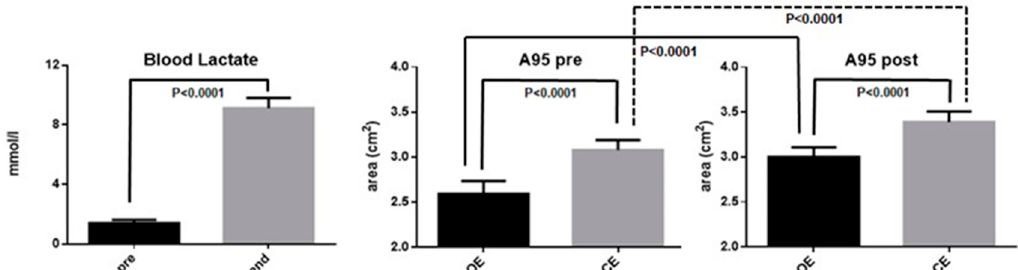
Figure 2. It can be seen, on the left, the mean value of blood lactate before and at the end of the exhaustive exercise. There are also shown the mean values of the area equivalent to 95% of the area designated by the CoP trajectory (A95), before and after the exercise. OE, open eyes; CE, closed